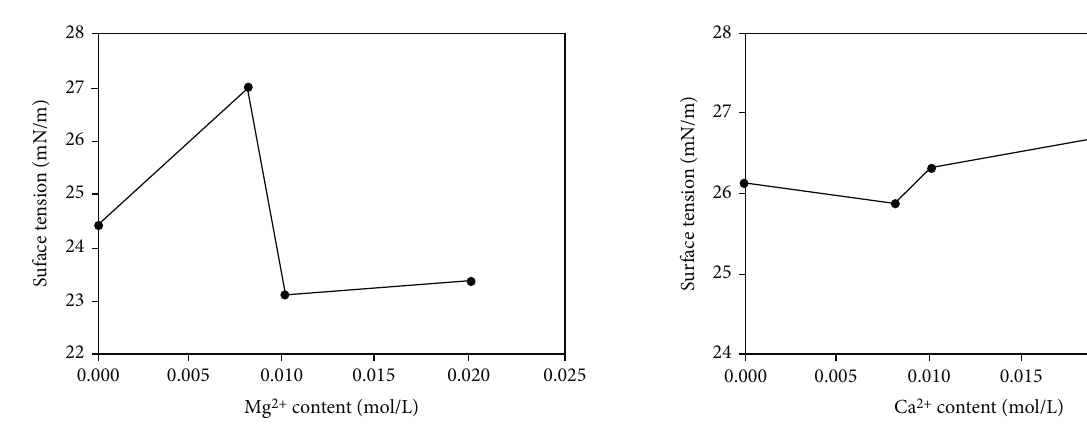
Figure 11: Relationship between Ca 2+ content and emulsion surface tension.